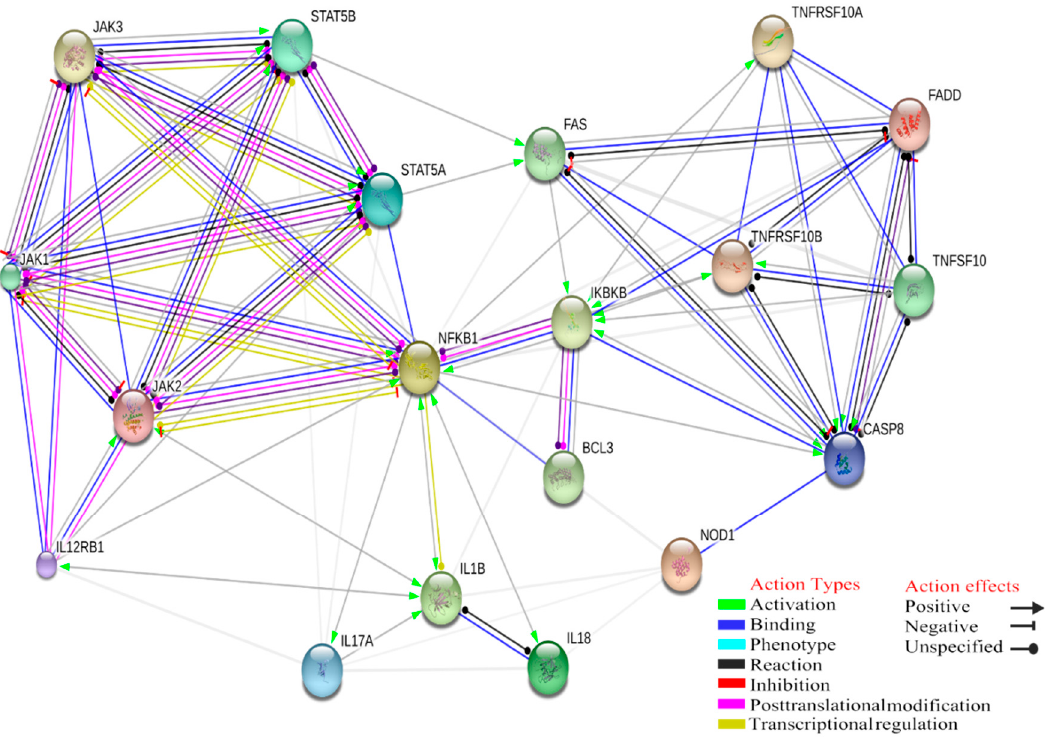
Figure 5. Interaction between IL-1 β and I-kB kinase / NF-kB signalling pathway, which have positive activation of Nuclear Factor Kappa B Subunit 1. NF-kB is a pleiotropic transcription factor present in almost all cell types. It is the endpoint of a series of signal transduction events initiated by a vast array of stimuli related to many biological processes such as inflammation, immunity, differentiation, cell growth, tumorigenesis and apoptosis. Positive activation of CASP8 (score: 0.900).